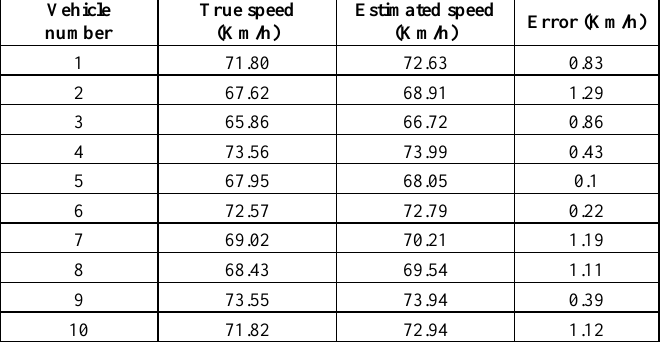
Table 1: Speed rate of detected moving